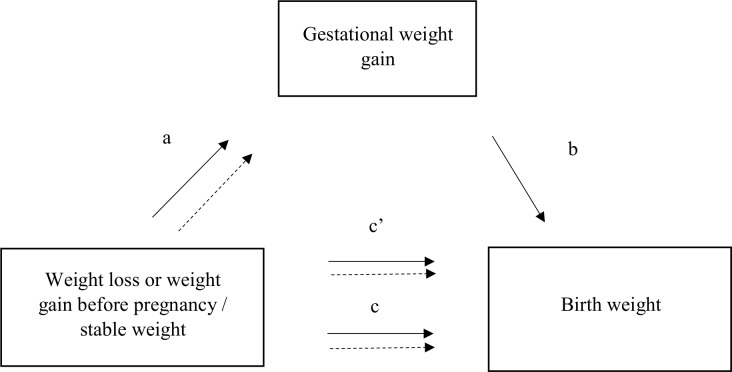
Mediator model.a is the association between weight variation and the potential mediator, gestational weight gain. b is the association between the potential mediator and the outcome variable, birth weight, adjusted for weight variation before pregnancy. a × b is the indirect effect. c is the total effect: overall association between weight variation and the outcome variable. c′ is the direct effect (non-mediated effect) adjusted for the mediator variable.